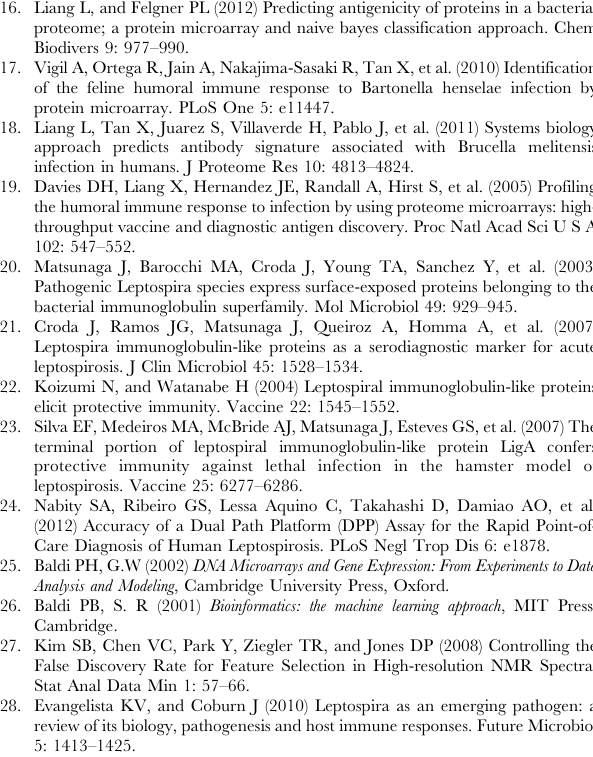
Figure S2 Overall IgG response of healthy controls from high endemic area. (A) IgG response of 10 MAT-positive and 10 MAT-negative endemic controls against 200 antigens is shown as a heatmap of reactivity according to the colorized scale with red strongest, black in-between and green weakest. (B) Average signal intensity of MAT-positive and MAT-negative endemic controls for some of the reactive antigens identified in this study. The green line shows the cut-off and antigens with average signal intensity below that line is not considered significant in this analysis. Figure S3 Correlation between MAT assay and array signal intensity. For each patient, the average signal intensity of the reactive antigens for acute (left) and convalescent (right) phase patients is plotted in the Y axis and the MAT titer in the X axis. Figure S4 Receiver operator characteristic curves. ROC curves for each differentially reactive antigen identified for convalescent-phase patients when compared to high endemic area group. The domains of the Lig proteins are highlighted on the bottom; antigens are sorted by decreasing AUC, from left to right, top to bottom. Table S1 List of protein features used for selecting ORFs that would compose the array.